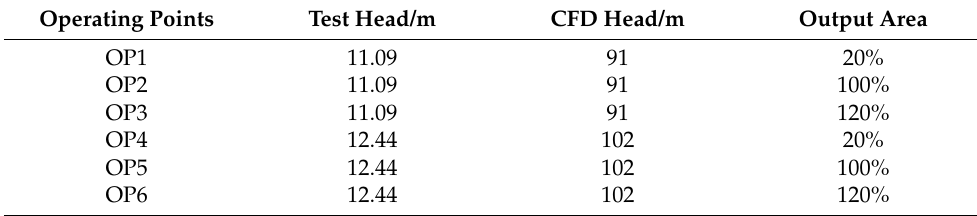
Table 5. Test operating points.